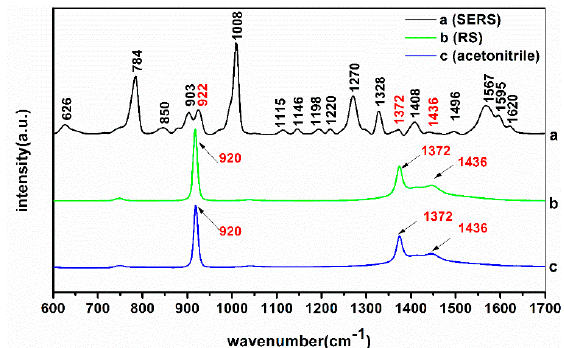
Figure 2. ( a ) Surface-enhanced Raman spectroscopy (SERS) of TBZ solution; ( b ) RS of TBZ solution; ( c ) RS of acetonitrile.